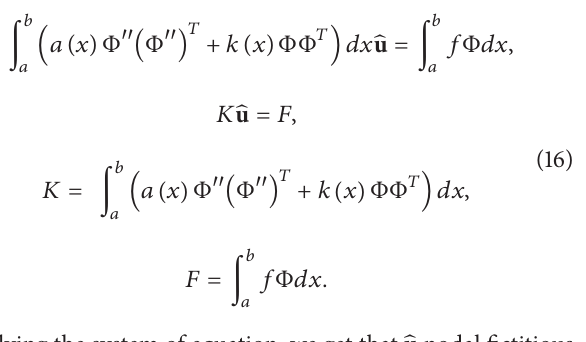
Figure 2: Derivatives of weight function in the support